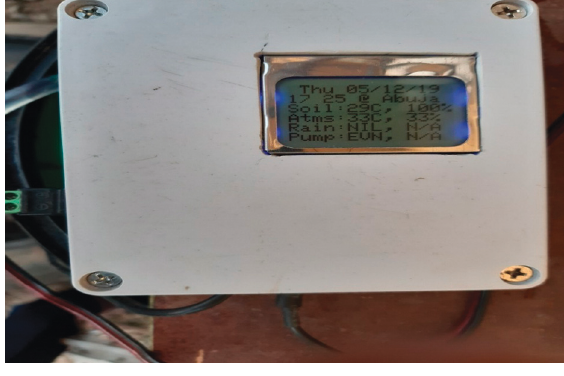
Figure 15: LCD output.